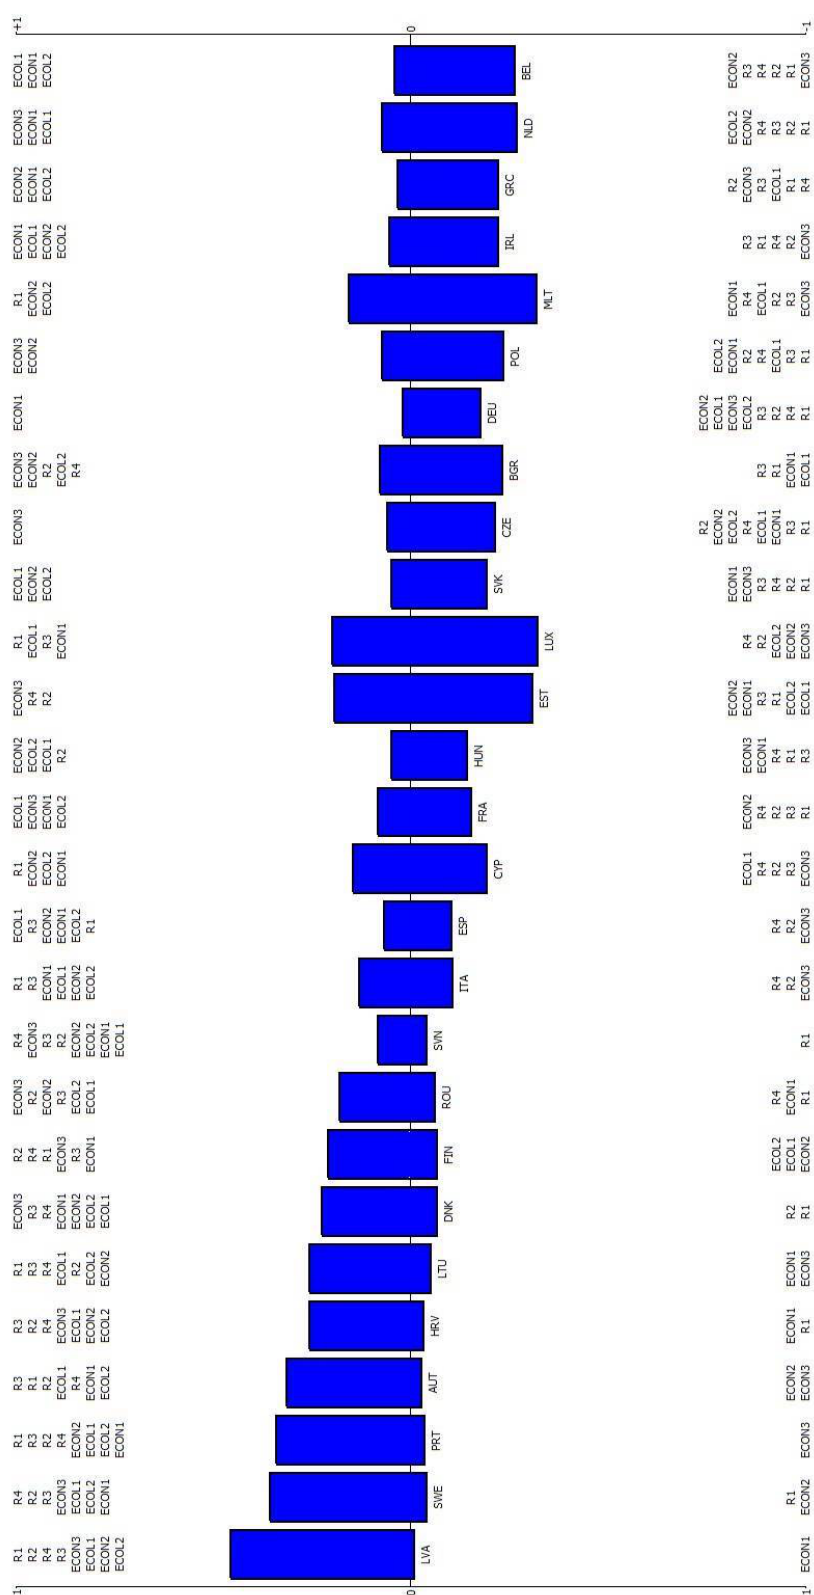
Figure A1. Rainbow diagram for 2014.